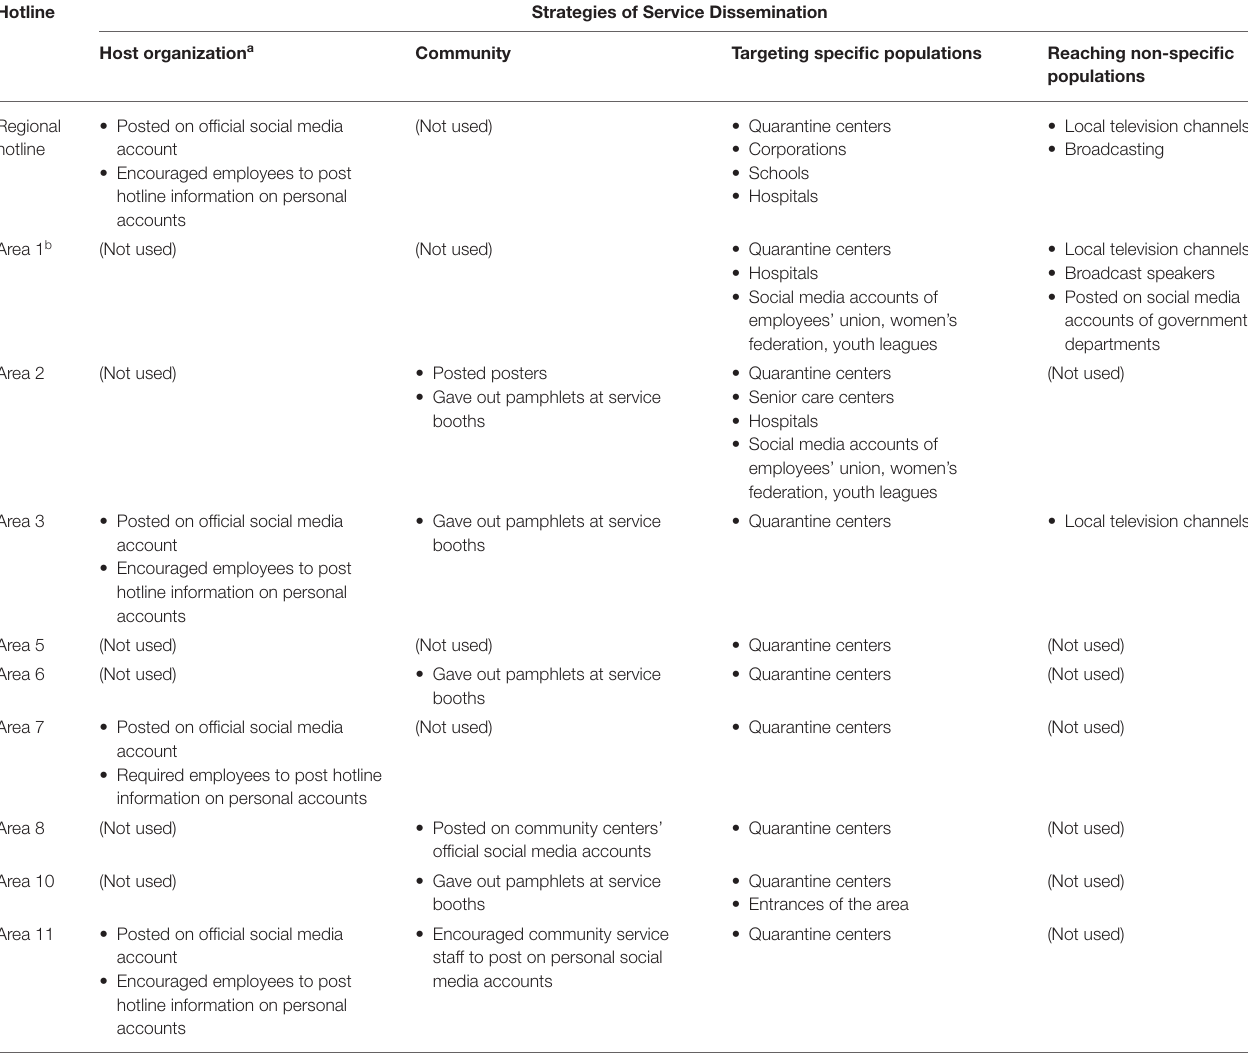
TABLE 2 | Hotline Service Dissemination